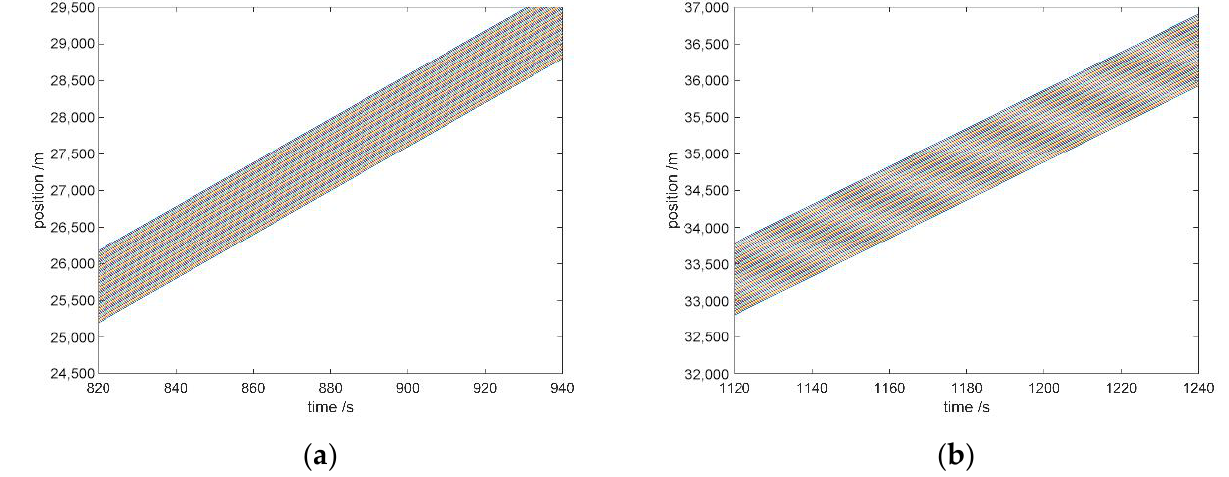
Figure 9. The operation of traffic flow affected by the generalized preceding vehicles (GPV) information in the vehicles to everything (V2X) environment: ( a ) Before exerting the disturbance; ( b ) After exerting the disturbance.